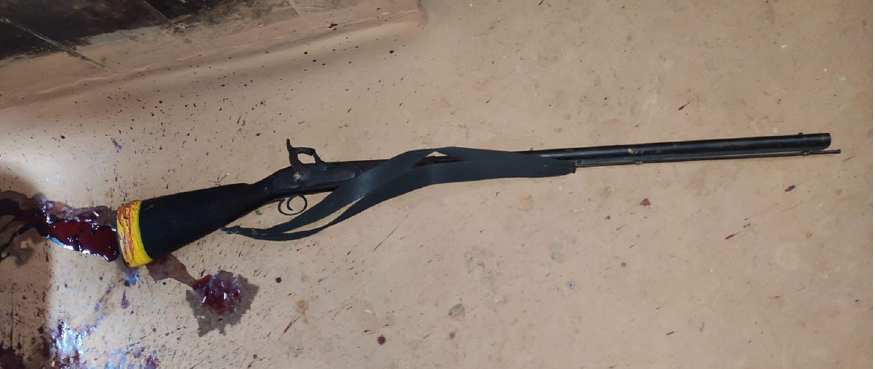
Figure 4. The firearm recovered from the scene of